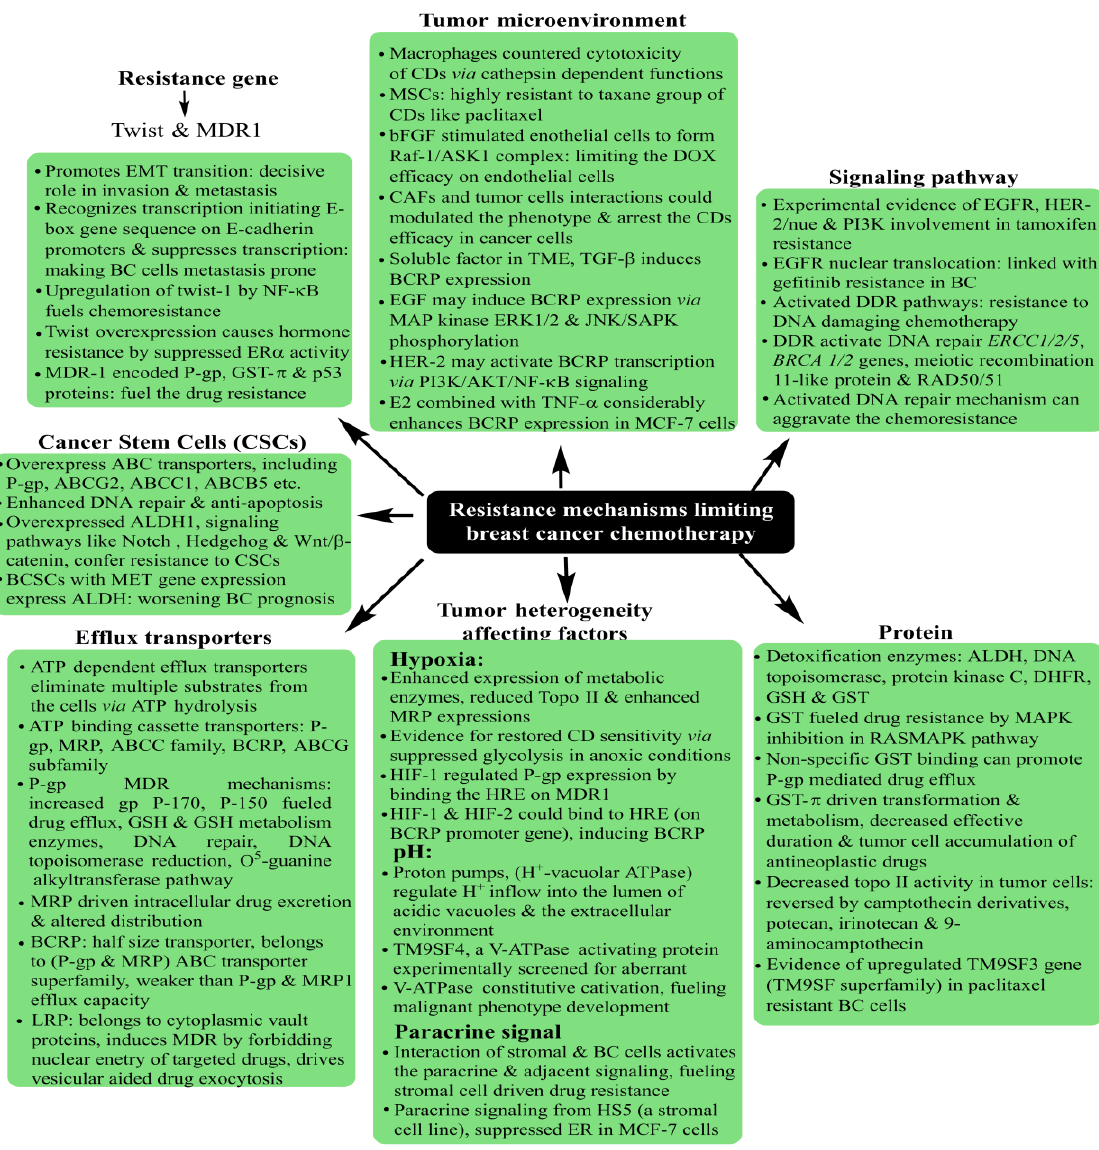
Figure 1. Summary of breast cancer chemoresistance mechanisms, collectively suggesting a need for combinatorial therapies and nanocarrier-assisted delivery as the counter alternatives [Abbrevia- tions: BC: breast cancer, BCRP: breast cancer resistance protein, MDR: multiple drug resistance,